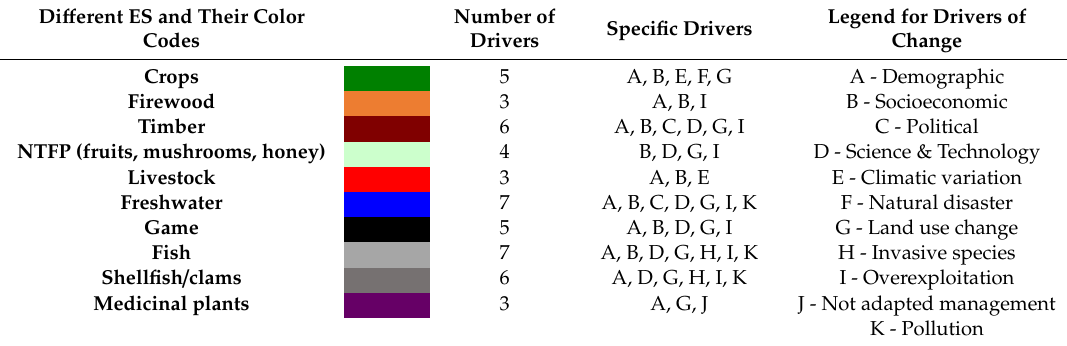
Table 3. Drivers of change of di ff erent provisioning services available in the two villages. Di ff erent ES and Their